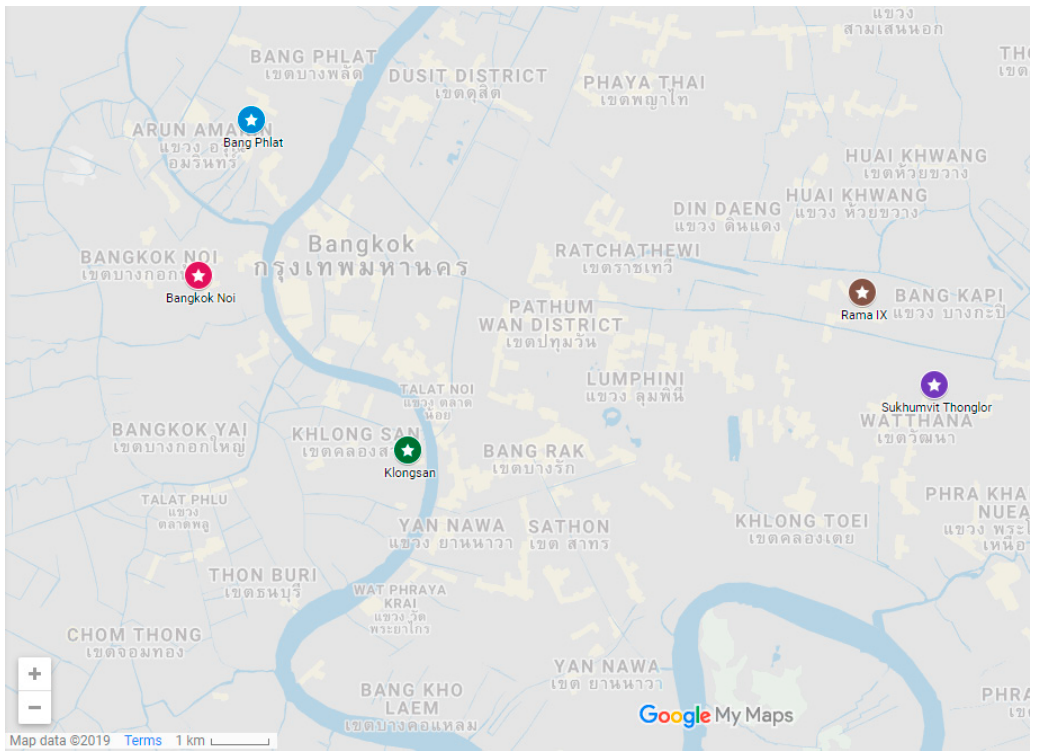
Figure 1. Map of five neighborhoods in the Bangkok Metropolitan Area in which the five studied high-rise housing estates are located. Source: Google My Maps.